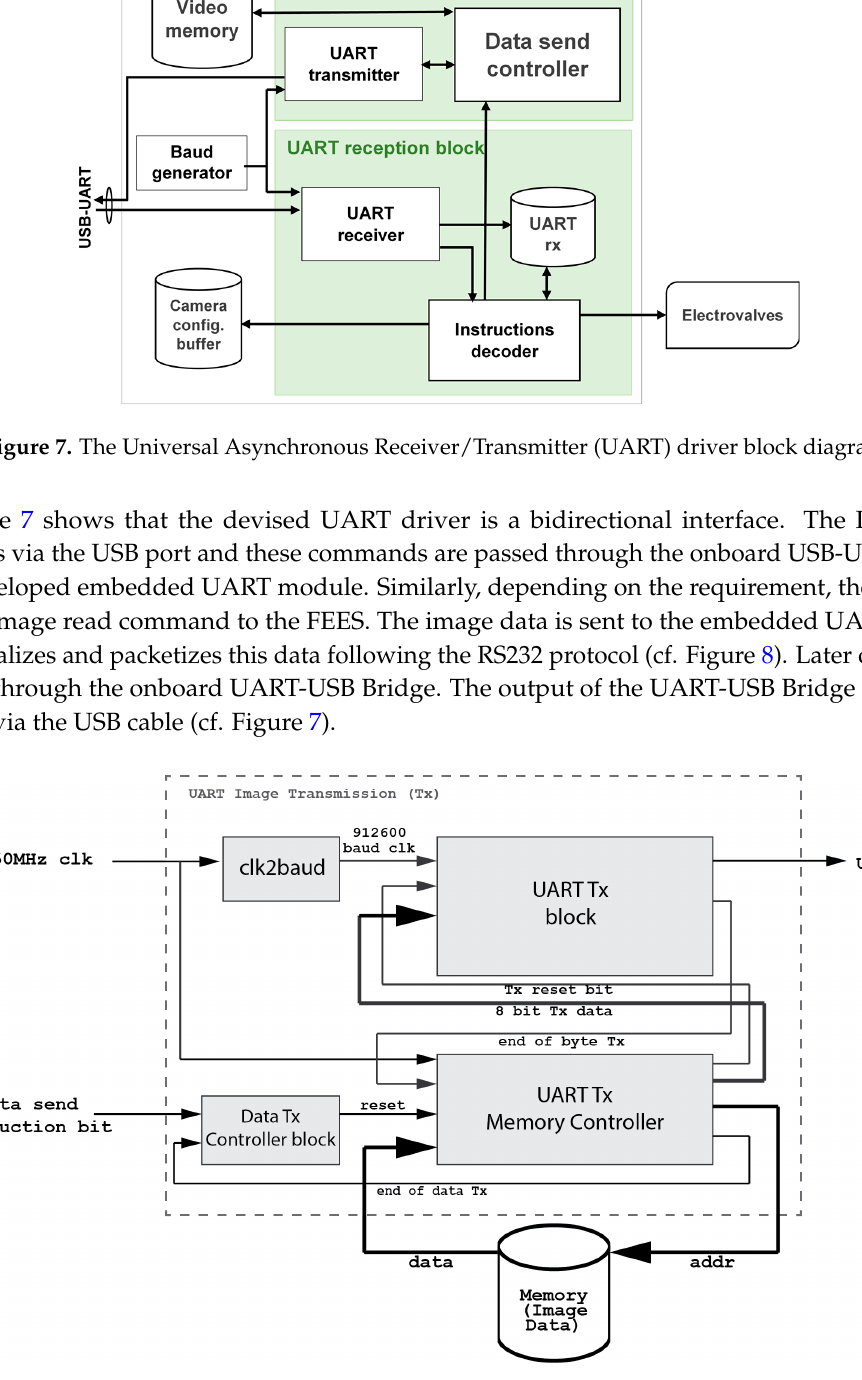
Figure 8. A detailed block diagram of the UART transmitter (Tx).